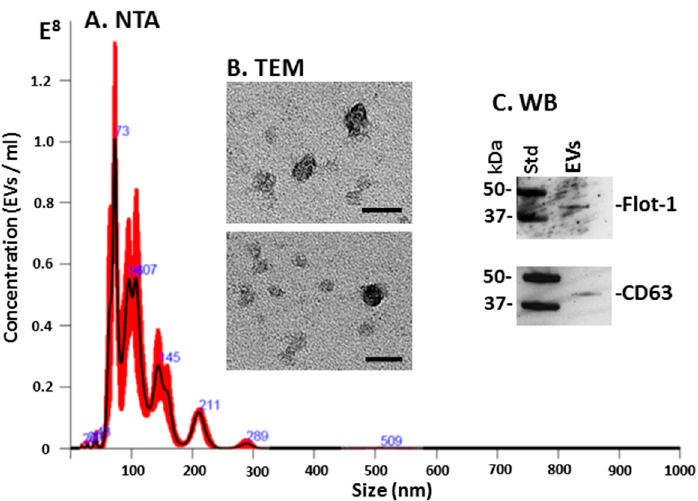
Figure 1. Strongylocentrotus purpuratus coelomic fluid EV profile. ( A ) Nanoparticle tracking analysis (NTA) showing a representative size distribution profile of sea urchin coelomic fluid EVs, with the majority of EVs within a 30–300 nm range. ( B ) Transmission electron microscopy (TEM) from sea urchin coelomic fluid EVs; scale bar represents 50 nm. ( C ) Western blotting analysis (WB) showing sea urchin coelomic fluid EVs positive for Flot-1 and CD63, respectively; the molecular weight for the standard is indicated in kilodaltons (kDa).